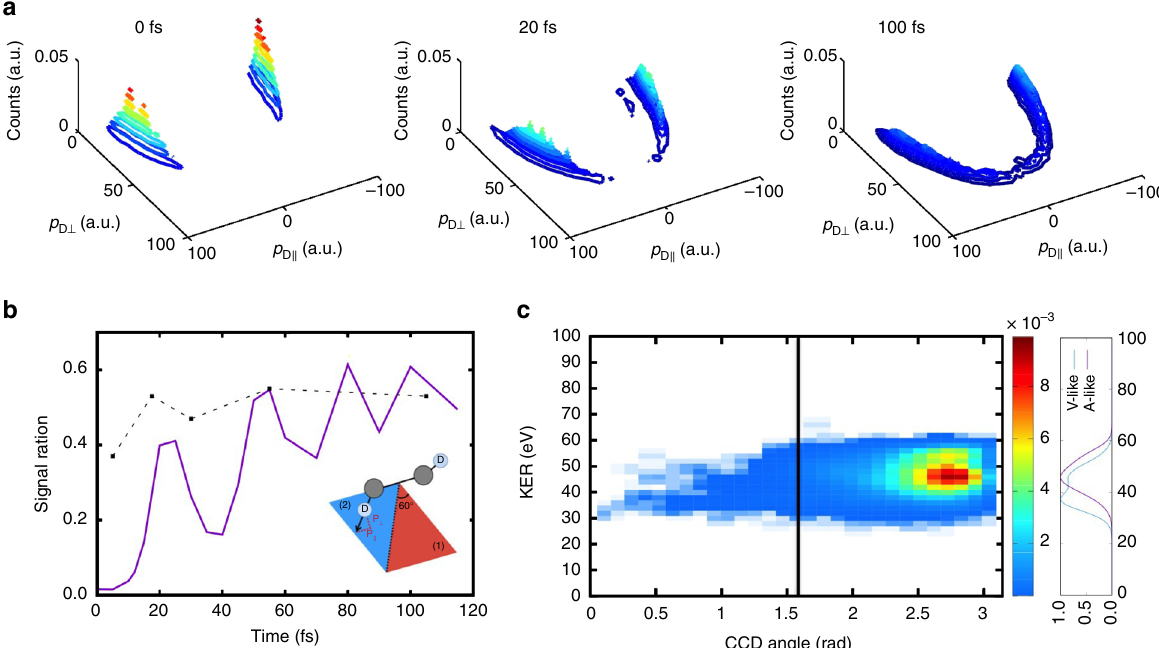
Fig. 4 Simulated Coulomb explosion momentum mapping signal. a Temporal evolution of the deuteron momenta from 0 to 100 fs (axes correspond to directions parallel and perpendicular to the C – C axis) with an assumed instrumental broadening of 3.8 × 10 − 22 kg m s − 1 . b Ratio of signal from red-shaded region where 0 (cid:5) (cid:6) tan (cid:1) 1 ð p jj = p ? Þ < 60 (cid:5) and blue-shaded region, where 60 (cid:5) (cid:6) tan (cid:1) 1 ð p jj = p ? Þ < 120 (cid:5) . Solid line is from simulations, which is compared with the experiments ( dashed line ). c The total kinetic energy release ( KER ) and angular distribution of C + /C + /D + /D + coincidences integrated over all time ð Þ½ (cid:4) p (cid:7) p D C a (cid:1) p C b delays. The CCD angle is de fi ned as ~ θ ¼ cos (cid:1) 1 sgn p C a 2